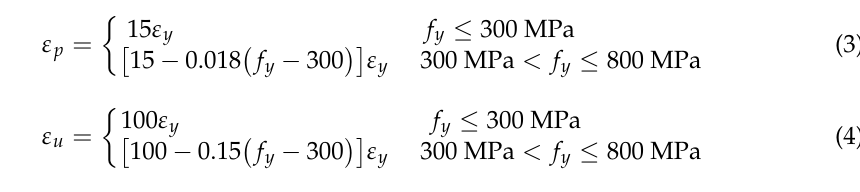
𝐸 is the initial elastic modulus corresponding to the beginning of strain hardening, (cid:3043)